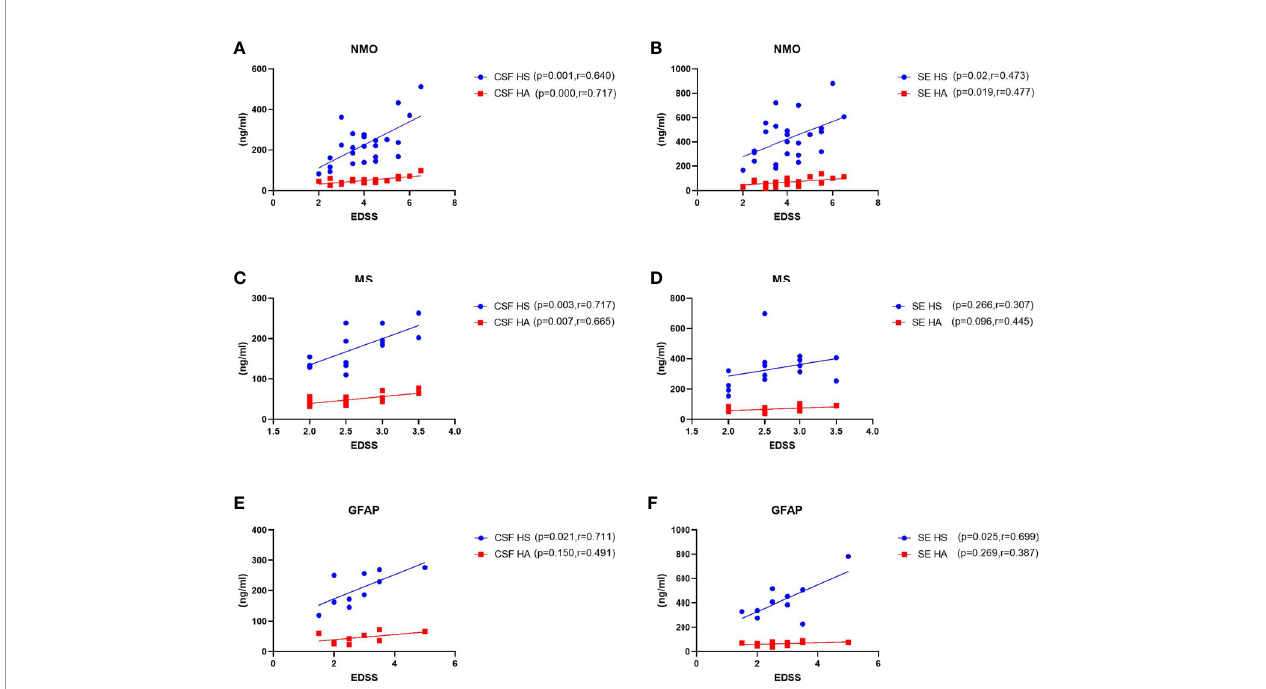
Figure 1B . serum HA: NMO p < 0.001, MS p<0.001, GFAP